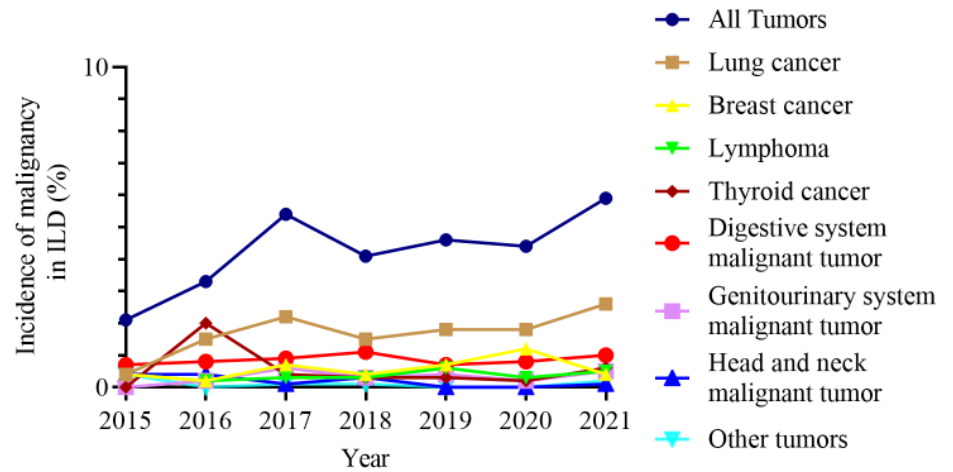
Figure 6. Prevalence of malignancies in ILD over time. ILD, interstitial lung disease. Table 6. Demographic characteristics and prevalence of malignancies in CTD-ILD and other types of ILDs.